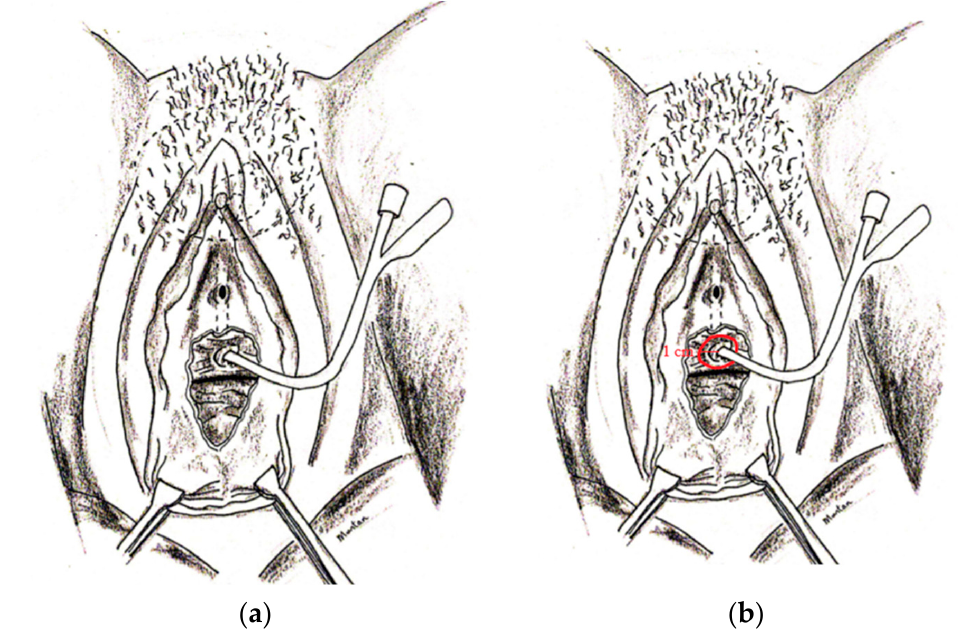
Figure 1. ( a )The VVF was exposed with vaginal blades and a Foley catheter was passed